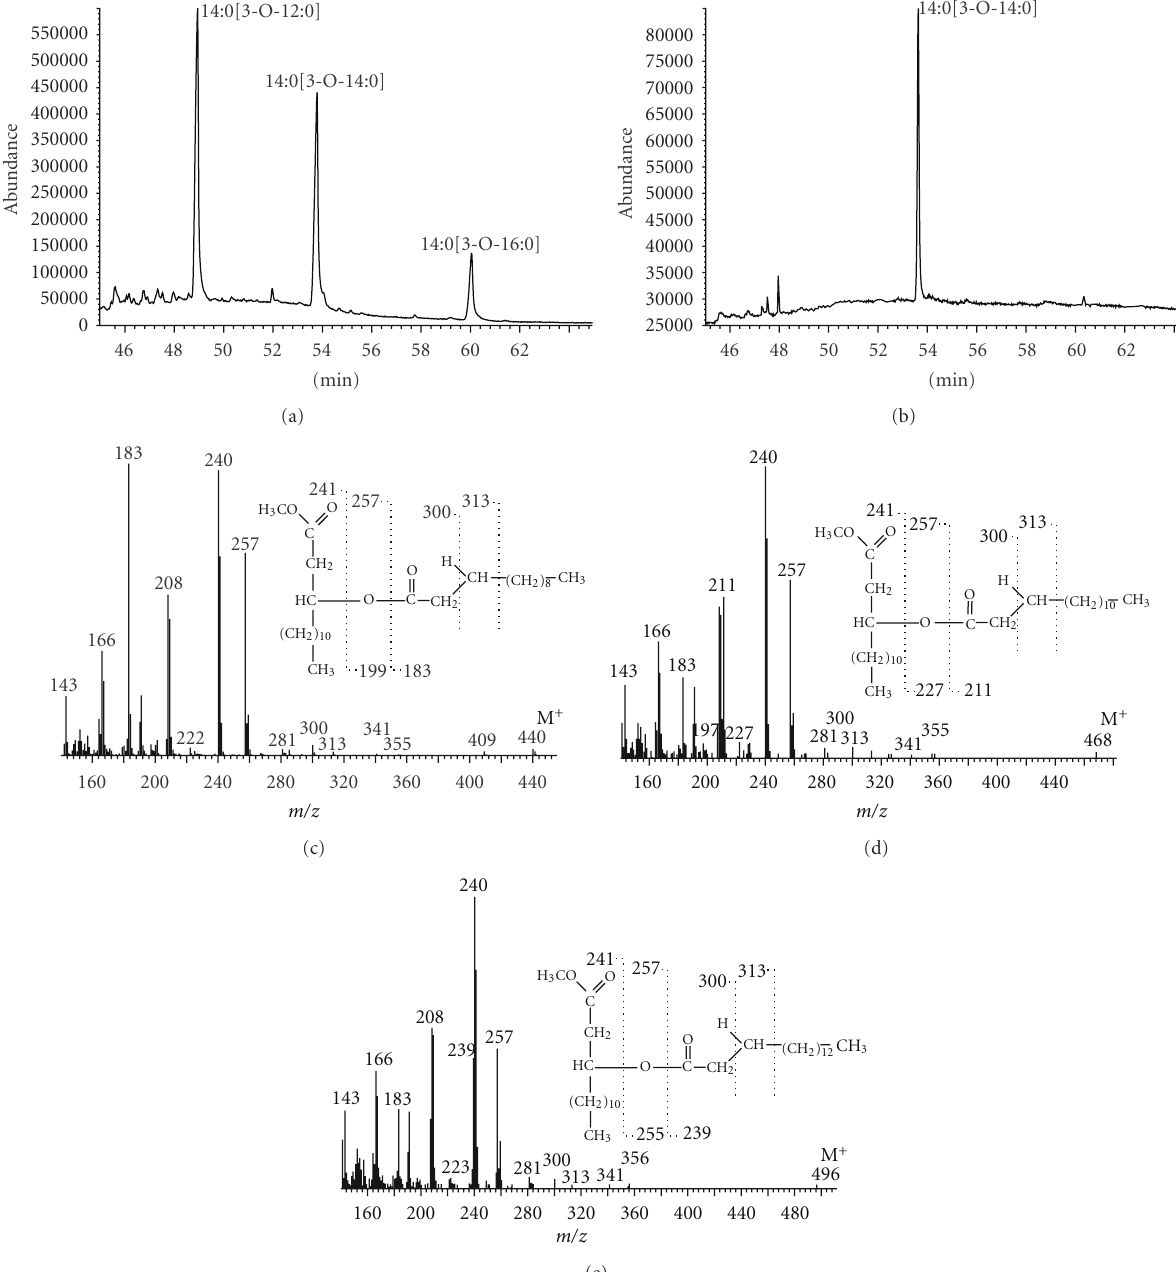
Figure 5: Chromatograms and mass spectra of 3-acyloxyacyl ligands of carbohydrate core of D. desulfuricans lipid A (chromatogram of derivatives obtained in the presence (a) and in absence (b) of methyl iodide; mass spectrum of 3-(dodecanoyloxy)tetradecanoic (c), 3- (tetradecanoyloxy)tetradecanoic (d), and 3-(hexadecanoyloxy)tetradecanoic (e) methyl esters).